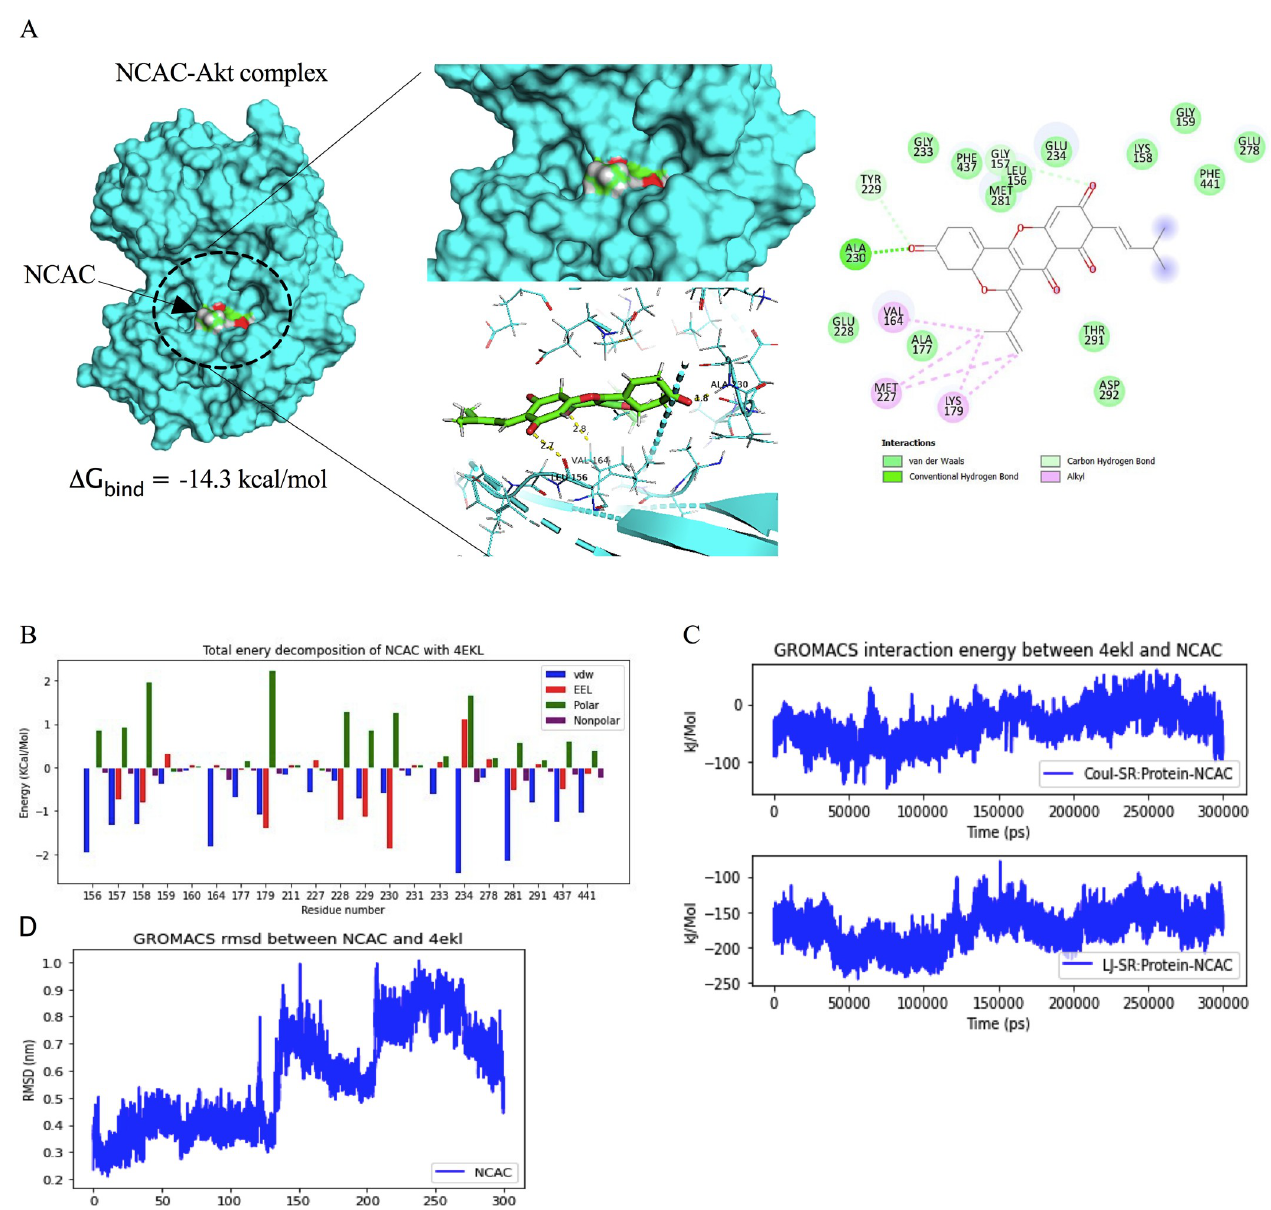
Fig 6. Docked model depicting interaction of norcycloartocarpin (NCAC) with Akt protein. ( A ) Binding mode and docking energy of NCAC bound to the binding site of Akt taken from the MD study. ( B ) Total energy decomposition of NCAC-Akt complex using the gmx_MMPBSA program. ( C ) The interaction energy between NCAC and Akt. ( D ) The RMSD plot for interaction of NCAC-Akt complex during 300 ns of molecular dynamic simulation.